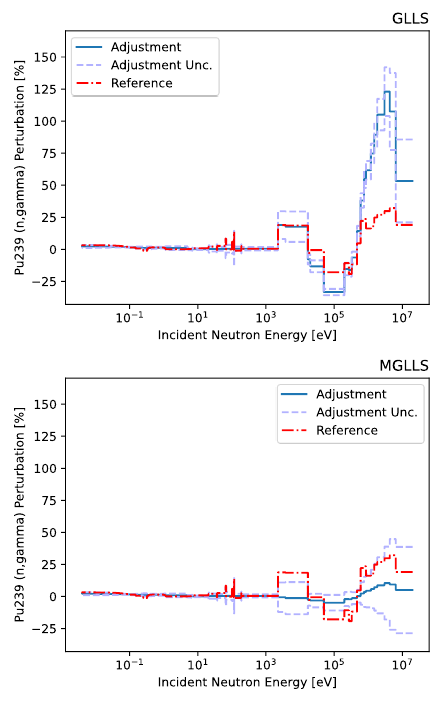
Fig. 2 Comparison of adjusted nuclear data #1